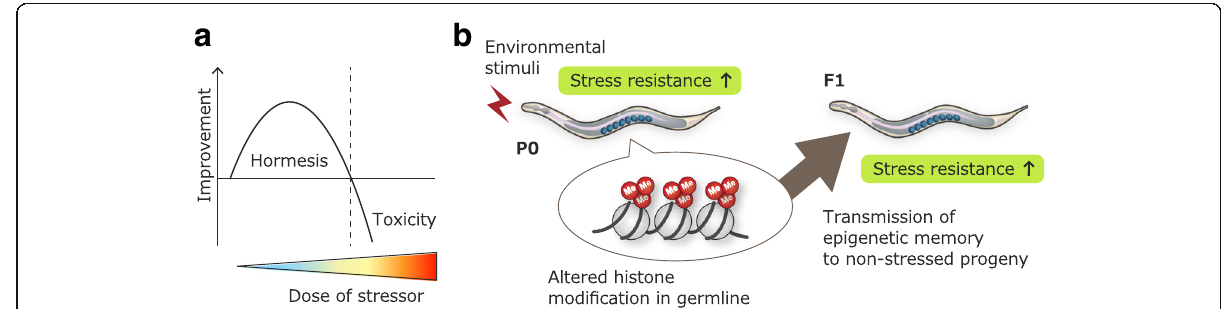
Fig. 3 Transgenerational inheritance of acquired hormesis effects. a Bi-phasic dose-response curve. Low-dose treatment induces enhanced viability (hormesis effects), whereas exposure to high-dose stressors is detrimental. b Schematic model of heritable hormesis effects. Environmental stressors induce epigenetic alterations in the germline, which appear to be transmitted to the next generations and contribute to the viability of the offspring. Me, histone